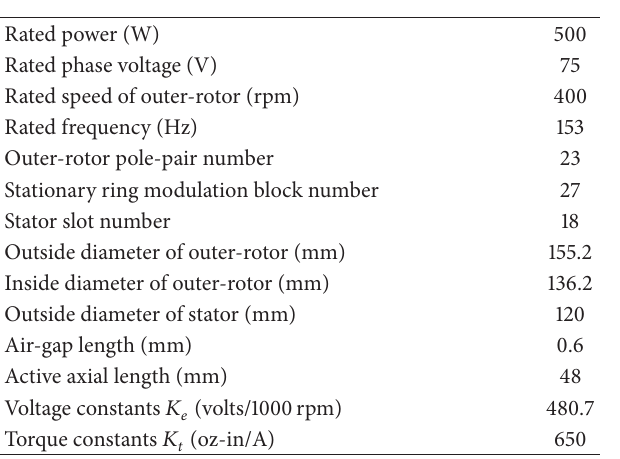
Table 1: Specifications of proposed PM motor.